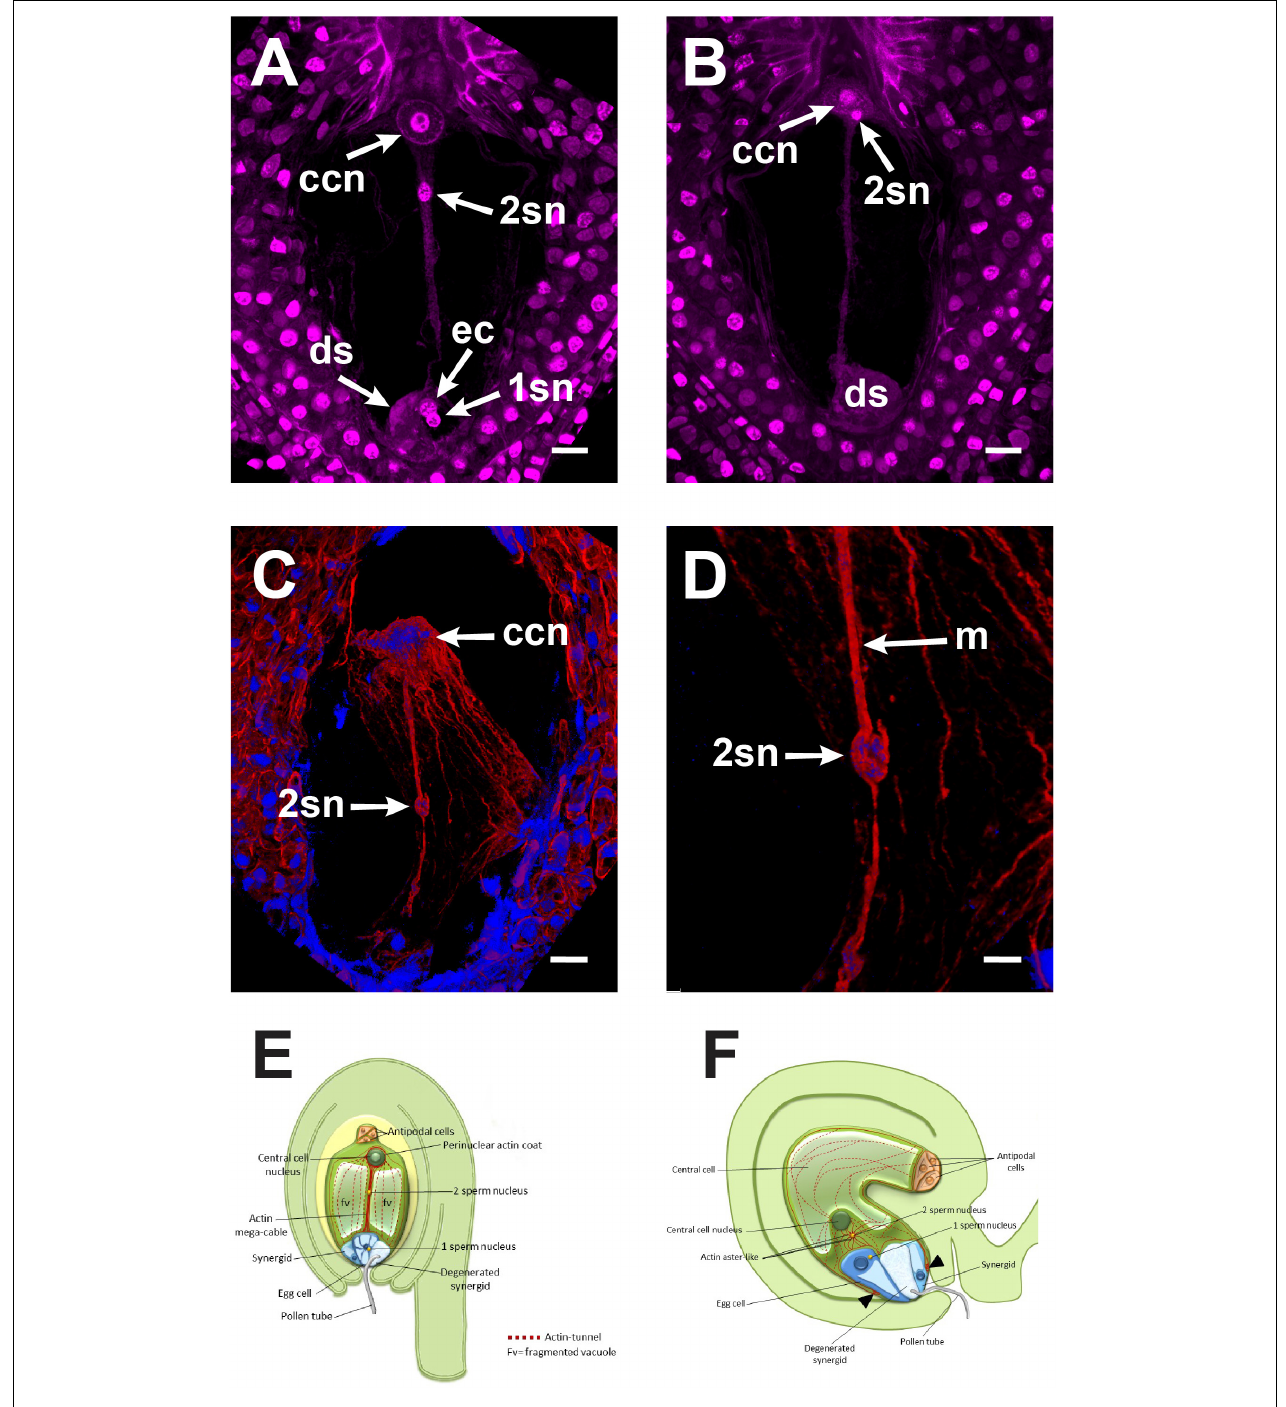
FIGURE 5 | The central cell fertilization of Agave inaequidens occurred from 38 to 42 HAP. (A) A cytoplasmic trans-vacuolar strand and the second sperm nucleus revealed by Feulgen staining were observed at the central cell. (B) Second sperm nucleus getting close to karyogamy. (C) The rhodamine-phalloidin stained actin mega-cable traversing the central cell vacuole wrapped the second sperm nucleus (stained with Hoechst 33258). (D) Close up of the sperm (in C) wrapped by actin. (E) Model of the central cell fertilization in Agave embryo sac where an actin-based mega-cable traverses the central vacuole, wraps the sperm nucleus and supports its migration for the second karyogamy event. (F) In Arabidopsis , during the second fertilization, the sperm nucleus is surrounded by an aster-shaped structure that moves it toward the central cell one (inspired in Dresselhaus et al., 2016). ccn, central cell nucleus, 2sn = second sperm nucleus, ec, egg cell; ds, degenerated synergid; m, actin mega-cable. All micrographs are z-stack projections oriented with the chalazal pole at the top. Bar in (A–C) = 20 µ m and (D) = 10 µ m.